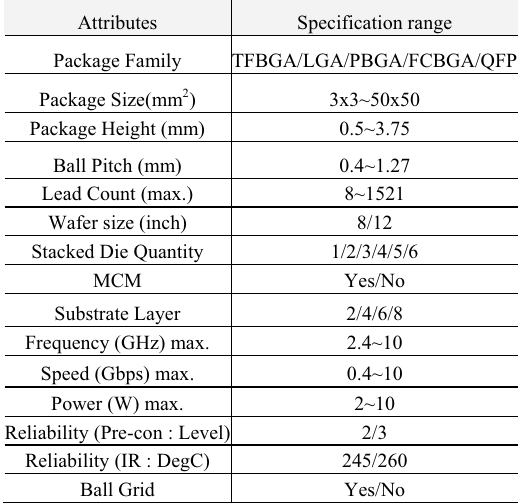
Table 2. Features and specification range in the IC packaging dataset.